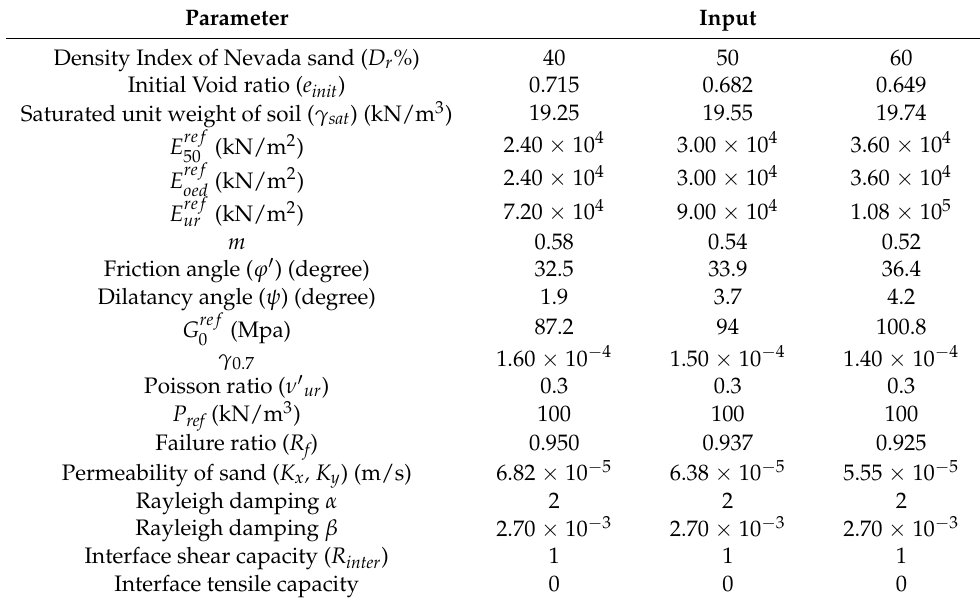
Table 1. Properties of the soil incorporated in the HSS model for the static